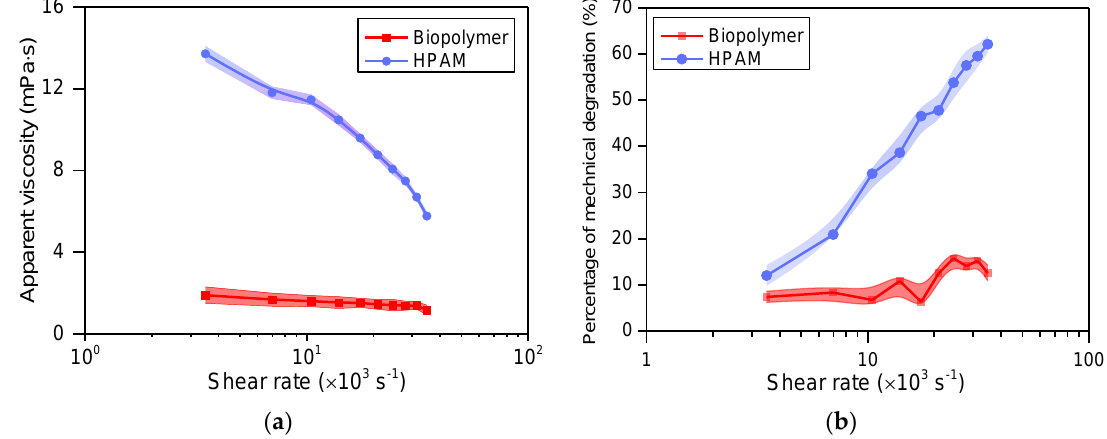
Figure 10. Apparent viscosity ( a ) and mechanical degradation ( b ) of the polymer systems.